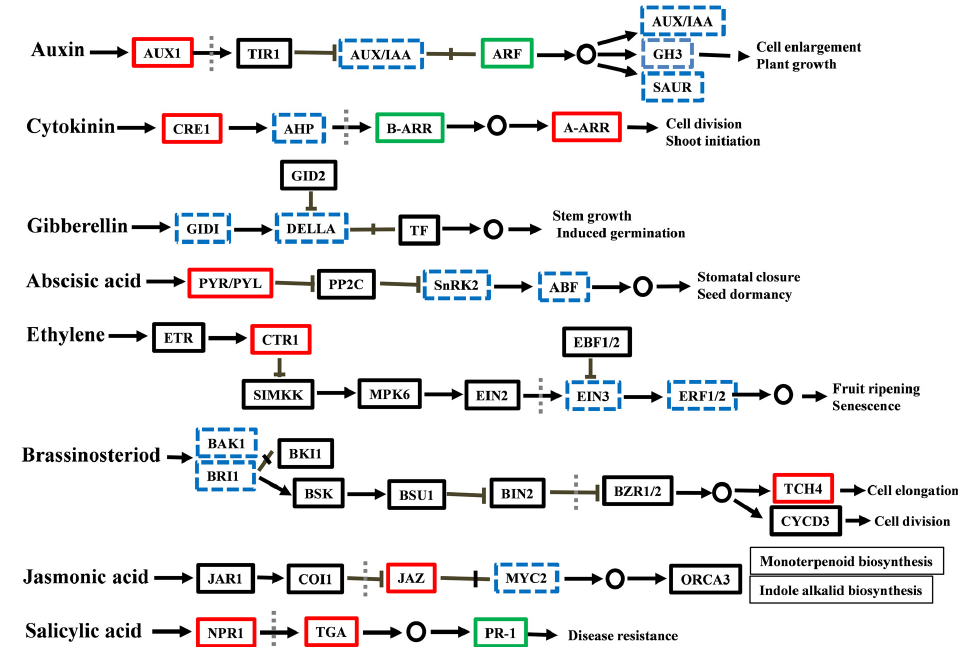
Figure 7. Differentially expressed genes (DEGs) were mapped to plant hormone signal transduction pathways in the KEGG database. The upregulated genes are indicated with red, downregulated with green, both up and downregulated with blue dashed boxes, and there are no DEGs with black line boxes. Vertical dashed lines depict the